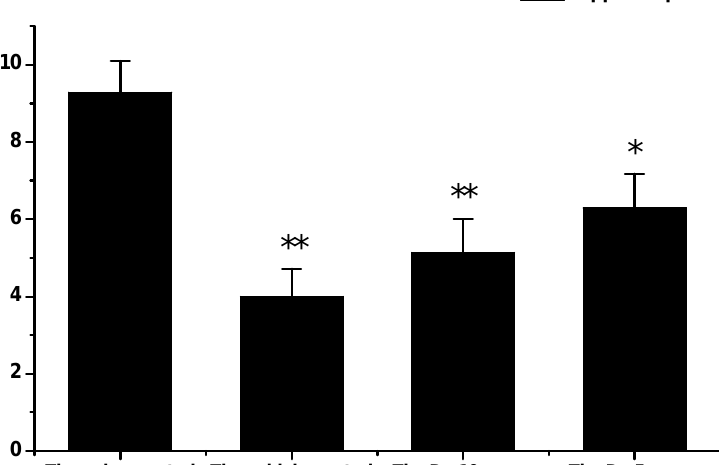
The areas indicated within the boxes in panels A–D were enlarged for better visualization in panels E–H. Scale bars (A–H): 100 µm. The bands below show the number of caspase-3 positive cells in mice hippocampus. Values are expressed as mean ± S.E.M (n = 7). *P < 0.05; **P < 0.01 vs. the aging